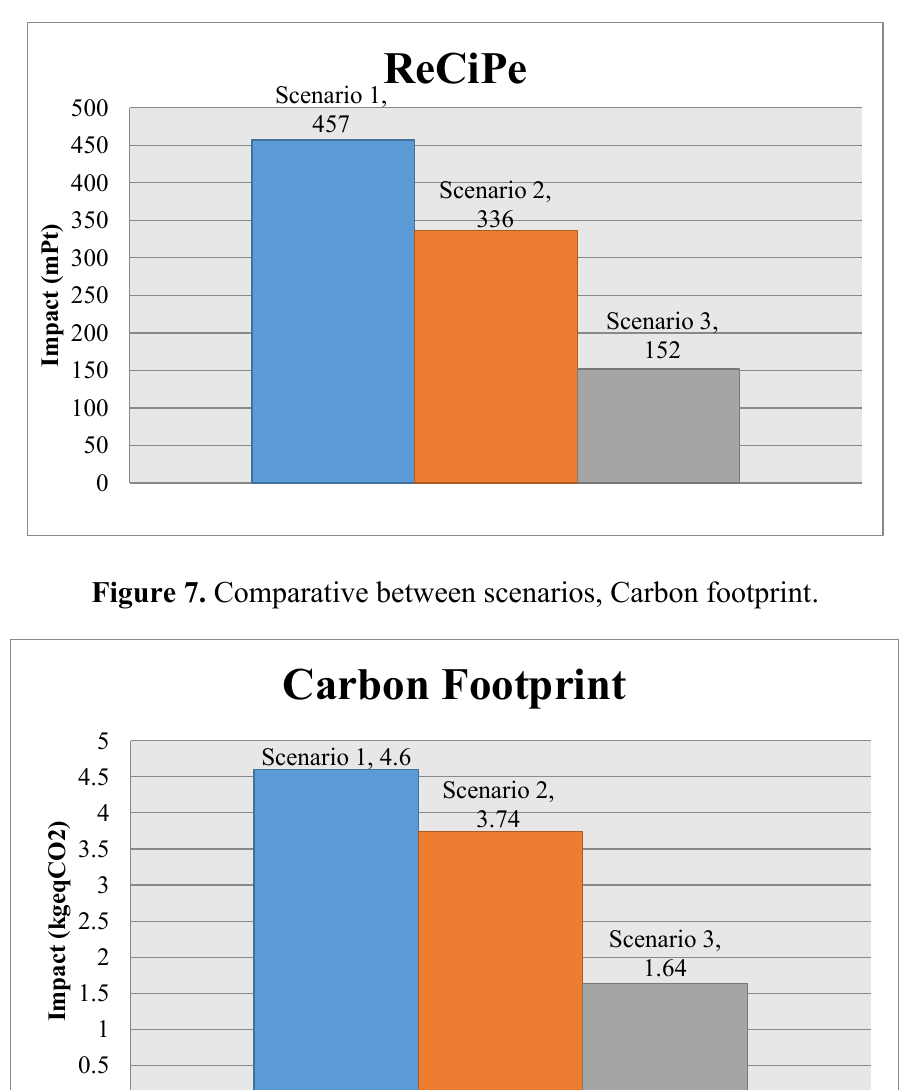
Figure 6. Comparative between scenarios, ReCiPe.